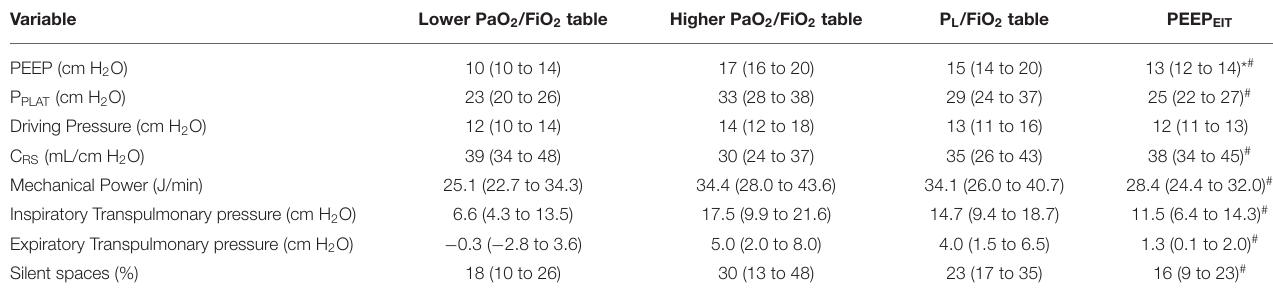
TABLE 1 | Effect of positive end-expiratory pressure (PEEP) settings on respiratory mechanics. Variable Lower PaO 2 /FiO 2 table Higher PaO 2 /FiO 2 table P L /FiO 2 table PEEP EIT